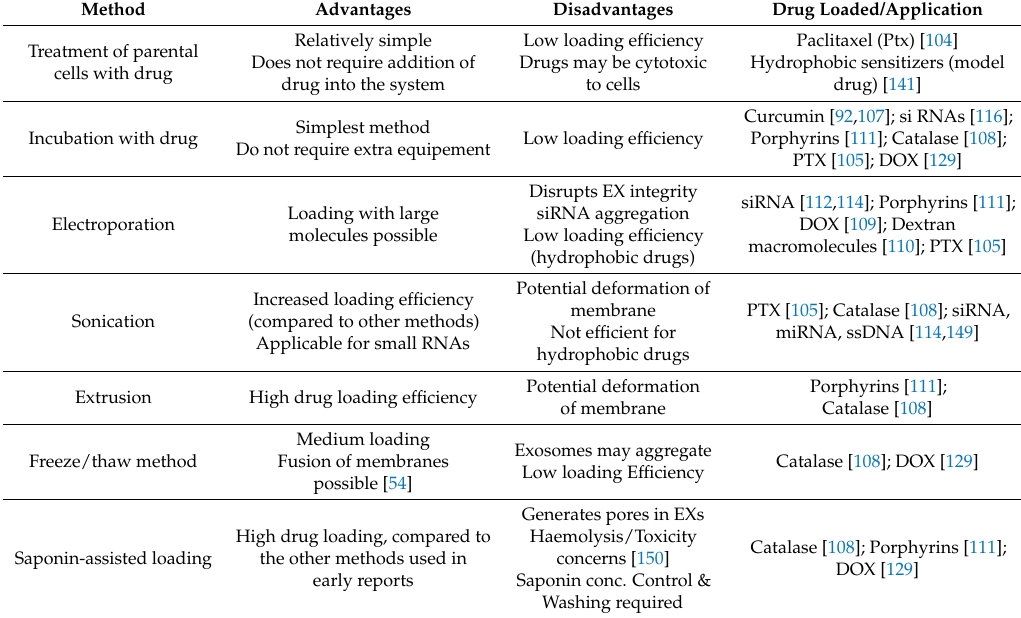
Table 1. Comparison of the early methods applied for drug loading into engineered extracelluar vesicles (EVs) or exosomes